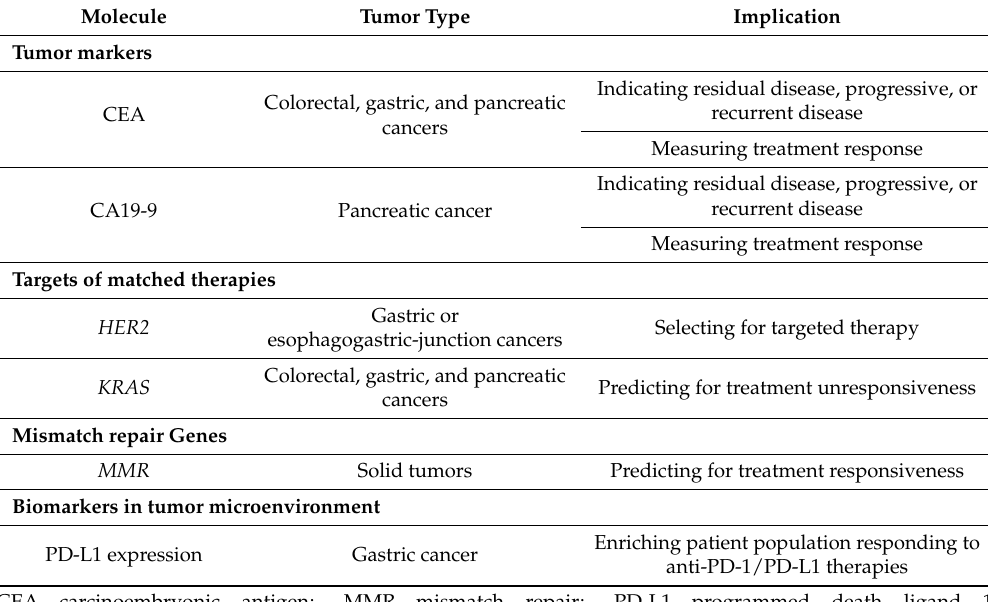
Table 1. Major molecular markers in clinical